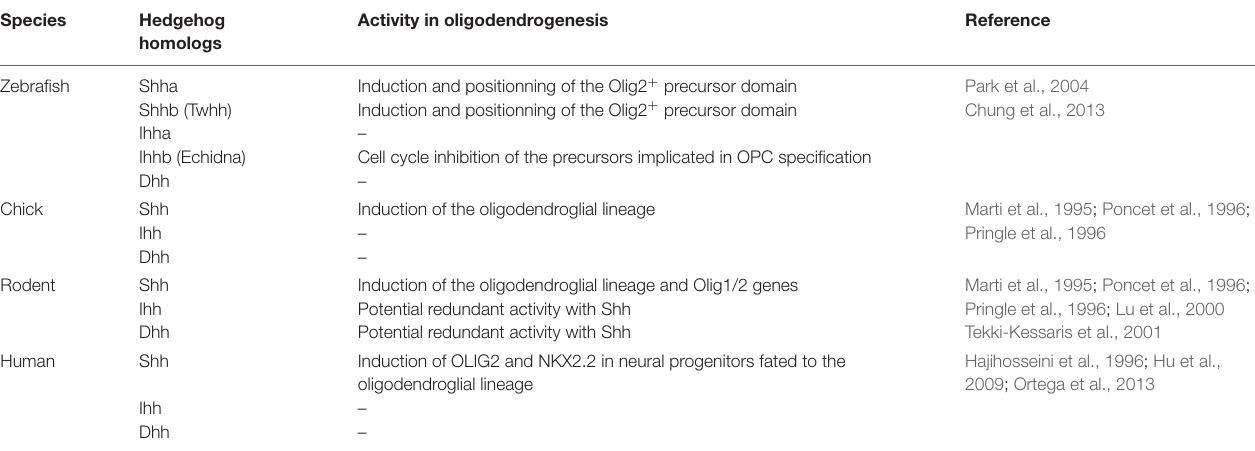
Species Hedgehog Activity in oligodendrogenesis homologs